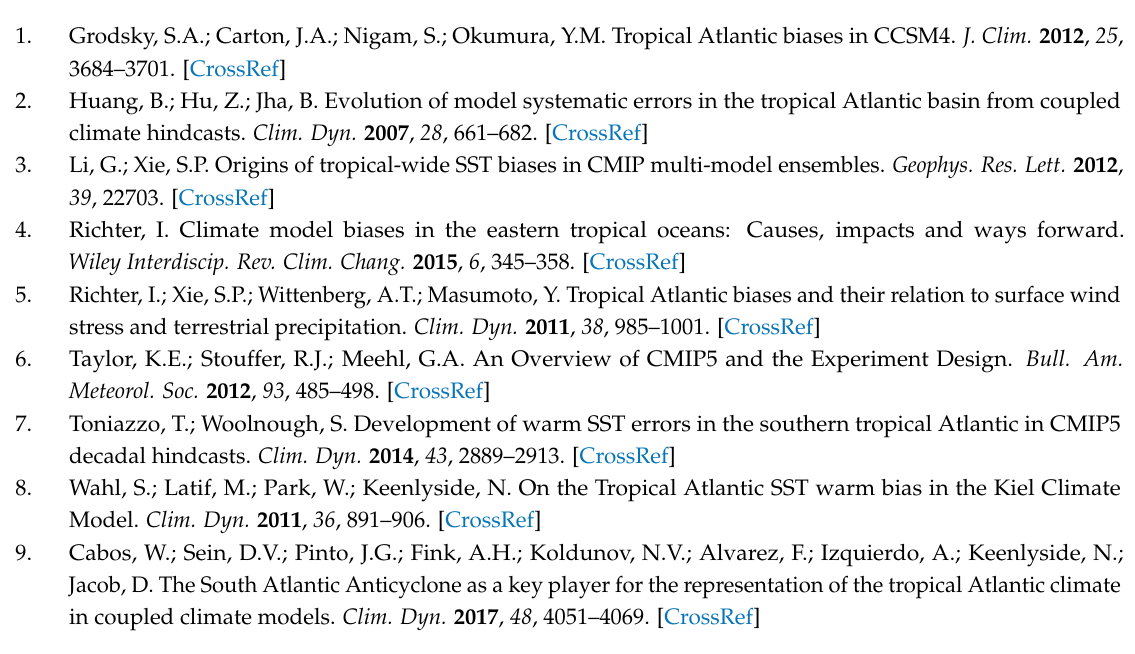
Figure S1: The annual-mean sea surface temperature (SST; units: ◦ C) bias during 1979–2005 of different coupled climate models (CCMs) in CMIP5 (a and c–v) and their ensemble mean (b) over the southern tropical Atlantic. The blue box denotes the Atlantic cold tongue (ACT; 10 ◦ S–3 ◦ N, 20 ◦ W–10 ◦ E) region, Figure S2: The same as Figure S1 but for the annual-mean surface zonal wind (units: m s − 1 ) bias. The blue box denotes the central and western equatorial Atlantic (5 ◦ S–5 ◦ N, 40 ◦ W–5 ◦ W), Figure S3: The same as Figure S1 but for the annual-mean surface meridional wind (units: m s − 1 ) bias. The blue box includes the ACT and the region south of it, Figure S4: The same as Figure S1 but for the surface air temperature (units: ◦ C) bias. The blue box includes the ACT region and the southeastern tropical Atlantic (SETA; 25 ◦ S–10 ◦ S, 10 ◦ W–15 ◦ E), Figure S5: The same as Figure S1 but for the surface specific humidity (units: g kg − 1 ) bias, Figure S6: The same as Figure S1 but for the precipitation (units: mm day − 1 ) bias. Note that, the color bar is reversed compared with that of the figures above, Figure S7: The same as Figure S1 but for the downward shortwave radiation (units: W m − 2 ) bias. The blue box includes the ACT and a part of the SETA region, Figure S8: Seasonal cycle of the SST (units: ◦ C) over the ACT region during 1979–2005 for HadISST (black dashes line), H_CCM (black solid line), U_MAM_nudg (green solid line), V_MAM_JJA_nudg (blue solid line), and U_V_nudg (red solid line). Table S1: CMIP5 models used in this study, Table S2: